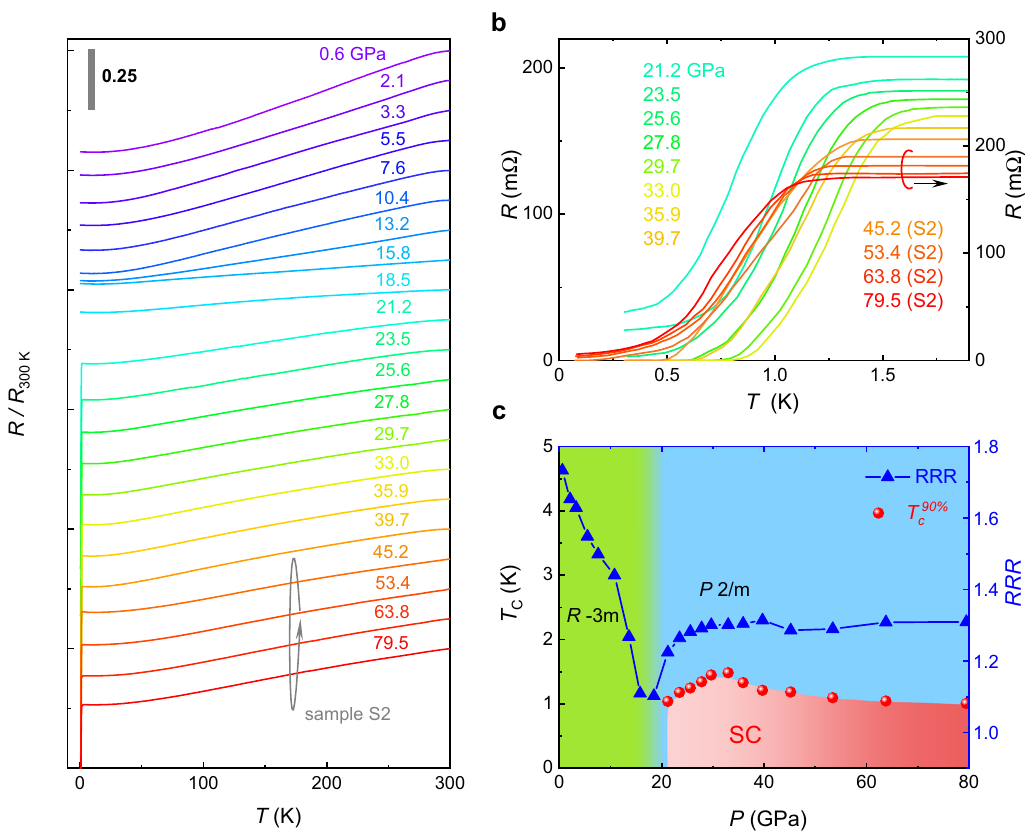
Fig. 4 Pressure-induced superconductivity in CsV 6 Sb 6 . a Temperature dependence of the resistance of CsV 6 Sb 6 normalized using the room temperature (300 K) value under various pressures up to 79.5 GPa. The curves taken at P < 40 GPa and P > 40 GPa are measured in samples S1 and S2, respectively. Data are shifted vertically for clearance. The gray vertical bar denotes a scale of 0.25. b An expanded view of the low-temperature resistance of CsV 6 Sb 6 in a pressure range of 21.2 – 79.5 GPa, showing the superconducting transitions. c Phase diagram for CsV 6 Sb 6 under pressure. The superconducting transition temperature T c (red solid circles) is determined as the temperature where the resistance drops to 90% of the normal state value. The shaded regimes shown in green and blue represents the rhombohedral (space group R (cid:1) 3 m ) and monoclinic (space group P 2/ m ) structural phases, respectively (see Supplementary Figs. 8,